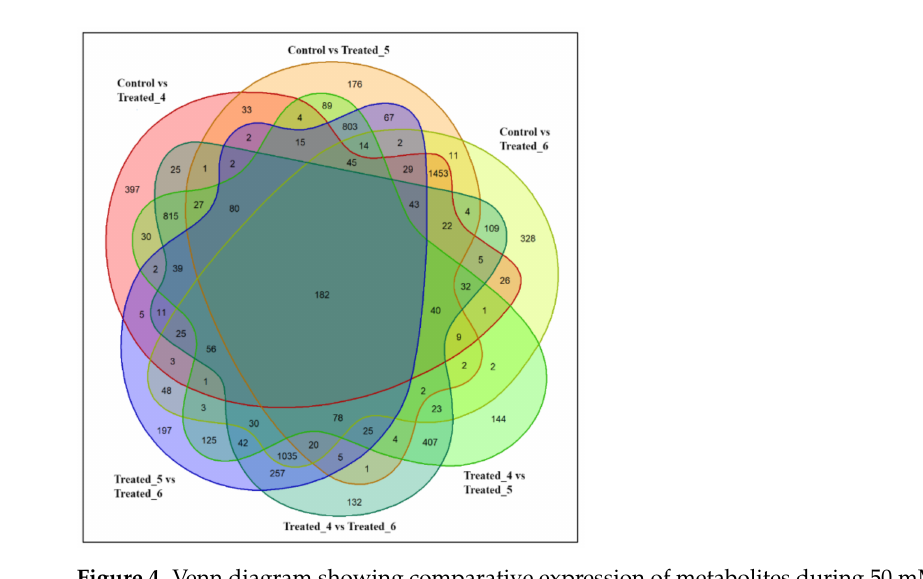
Figure 4. Venn diagram showing comparative expression of metabolites during 50 mM SA stressed condition in A. polystachya seedling.